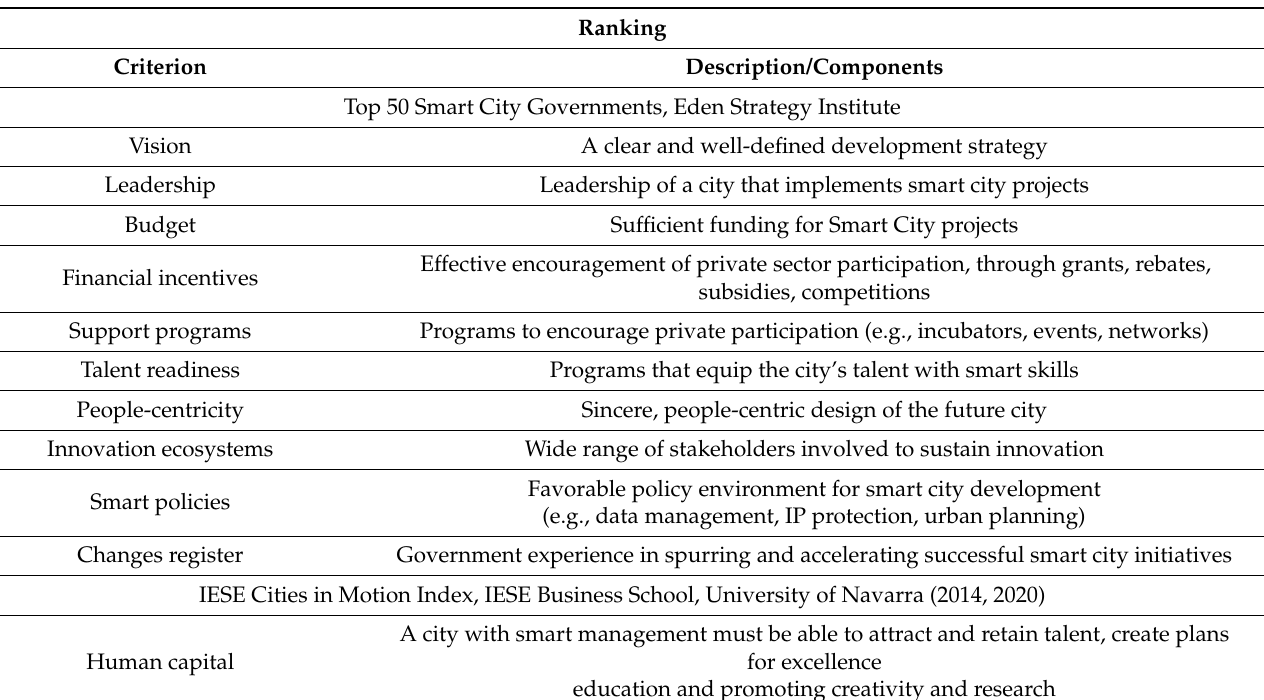
Table 2. Main criteria for evaluating “smart cities” based on selected